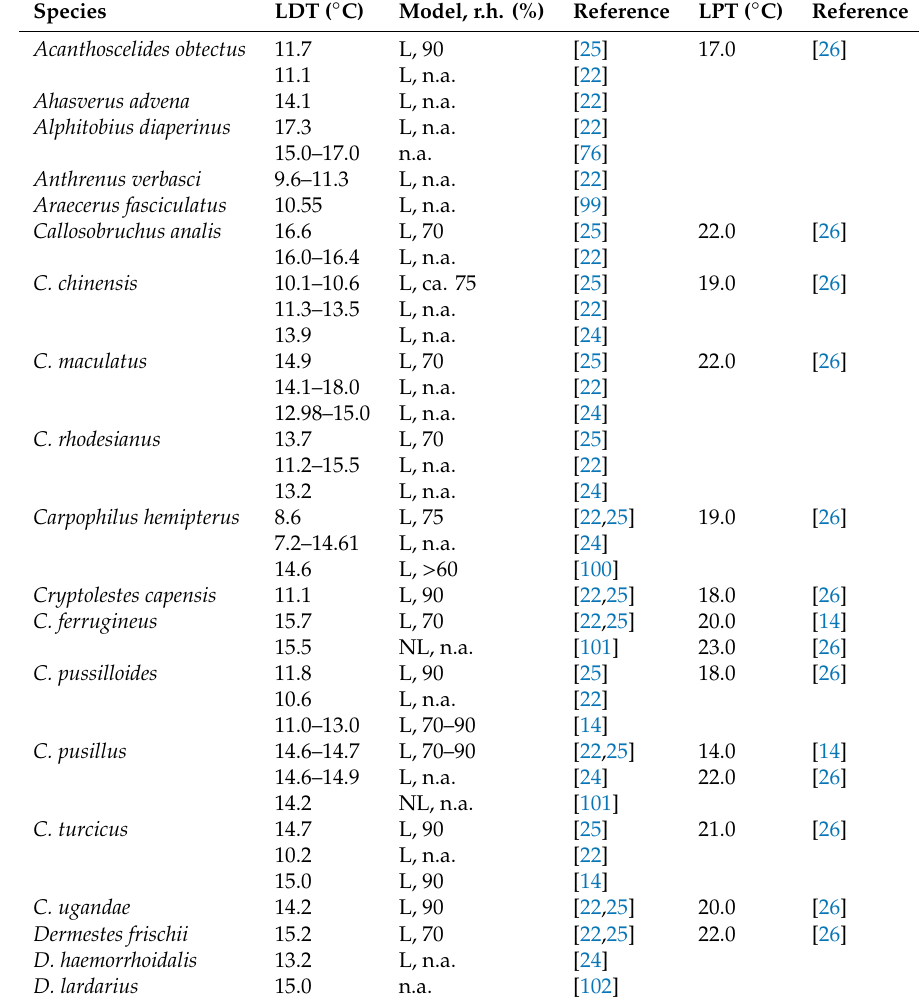
Table 2. Threshold temperatures for the individual (LDT) and population (LPT) development of selected stored product beetles. L—estimated based on linear model, NL—estimated based on non-linear model, n.a. —data are not